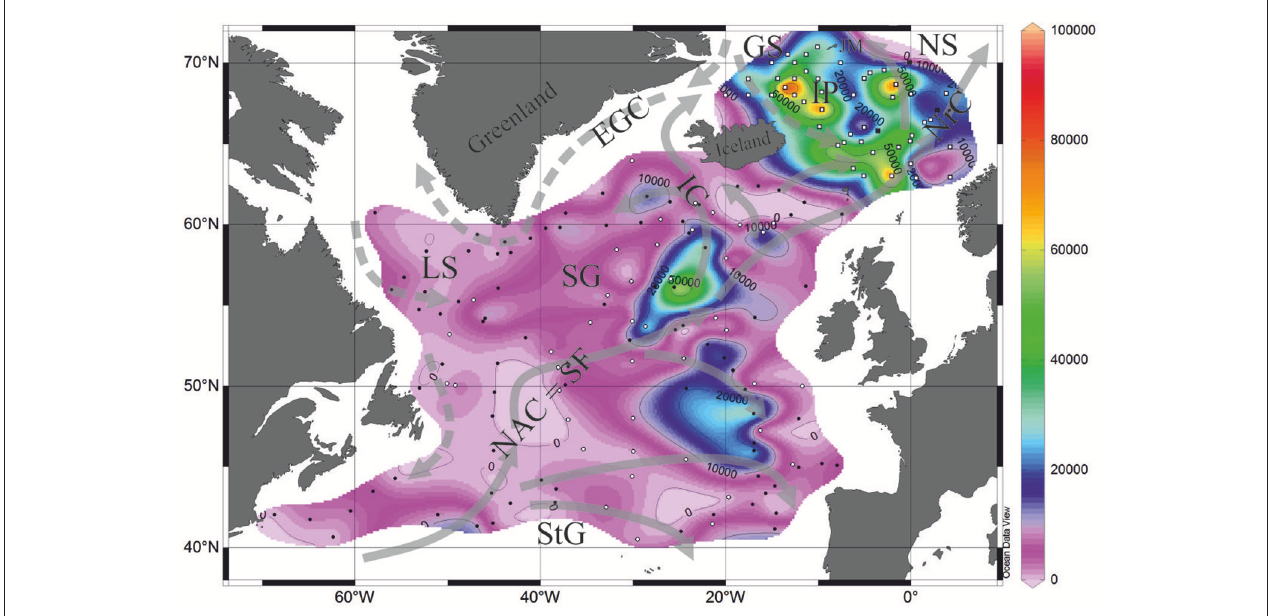
FIGURE 1 | Total radiolarian abundances in the bottom surface sediments (tests per 1g of bulk sediment). Black circles, data from Goll and Bjørklund (1971). White circles, data from Matul (1991). Black squares, data from Schröder-Ritzrau (1995). White squares, data from Bjørklund et al. (1998). Currents on the sea surface ( Gorshkov et al., 1977): gray solid lines show warm currents, gray dashed lines show cold currents. EGC, East Greenland Current; GS, Greenland Sea; IC, Irminger Current; IP, Iceland Plateau; JM, Jan Mayen; LS, Labrador Sea; NAC, SF; North Atlantic Current, Subpolar Front; NrC, Norwegian Current; NS, Norwegian Sea; SG, Subpolar Gyre; StG, Subtropical